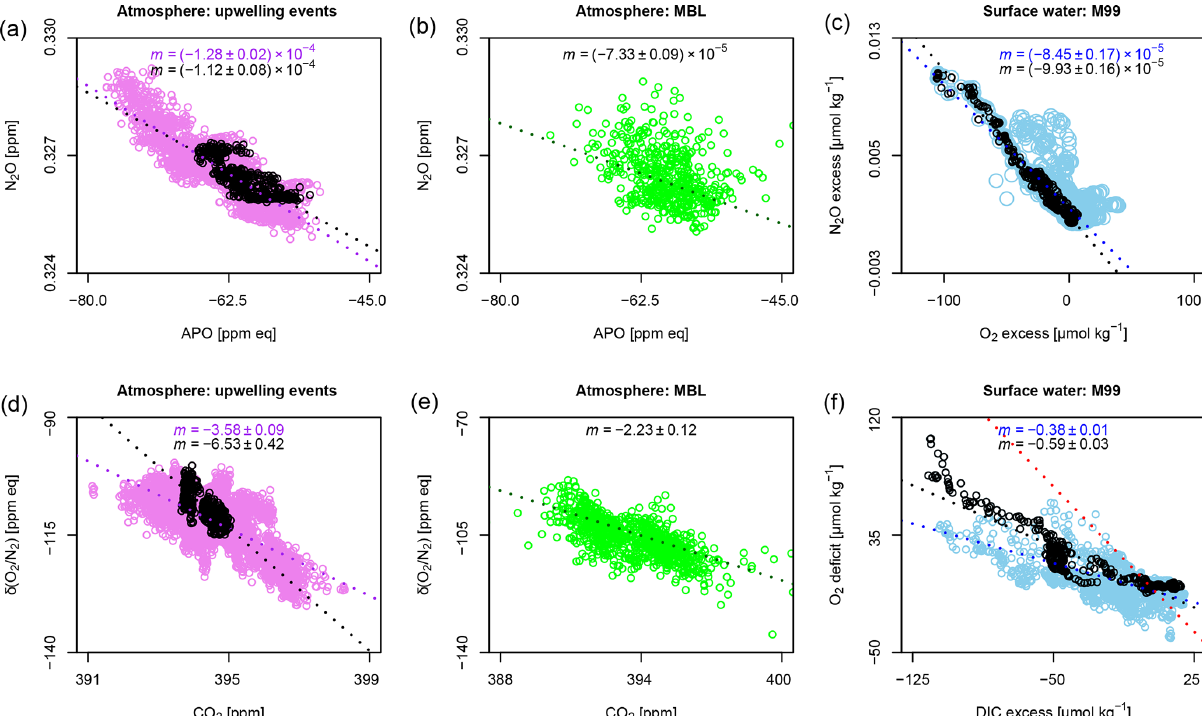
Figure 9. N 2 O and O 2 variability in the atmosphere and surface water. Comparison of the variability of O 2 with respect to N 2 O and CO 2 with respect to O 2 at NDAO and in surface water. Displayed are the data corresponding to atmospheric anomalies associated with upwelling events (a) , of all marine boundary layer air masses as selected by back-trajectories ( center ), and dissolved concentrations of CO 2 , N 2 O, and O 2 during M99 (b) . Atmospheric O 2 is expressed as APO in ppm equivalents, and dissolved concentrations are expressed as the difference between the measured concentration and the concentration at saturation, i.e., an excess, except for (f) , where it is shown as a deficit. In that plot, the Redfield ratio of 1.45 is plotted as a dotted red line for reference. Slopes ( m ) are given at the top of each plot. The black circles correspond to the upwelling event encountered during M99 (see Fig.